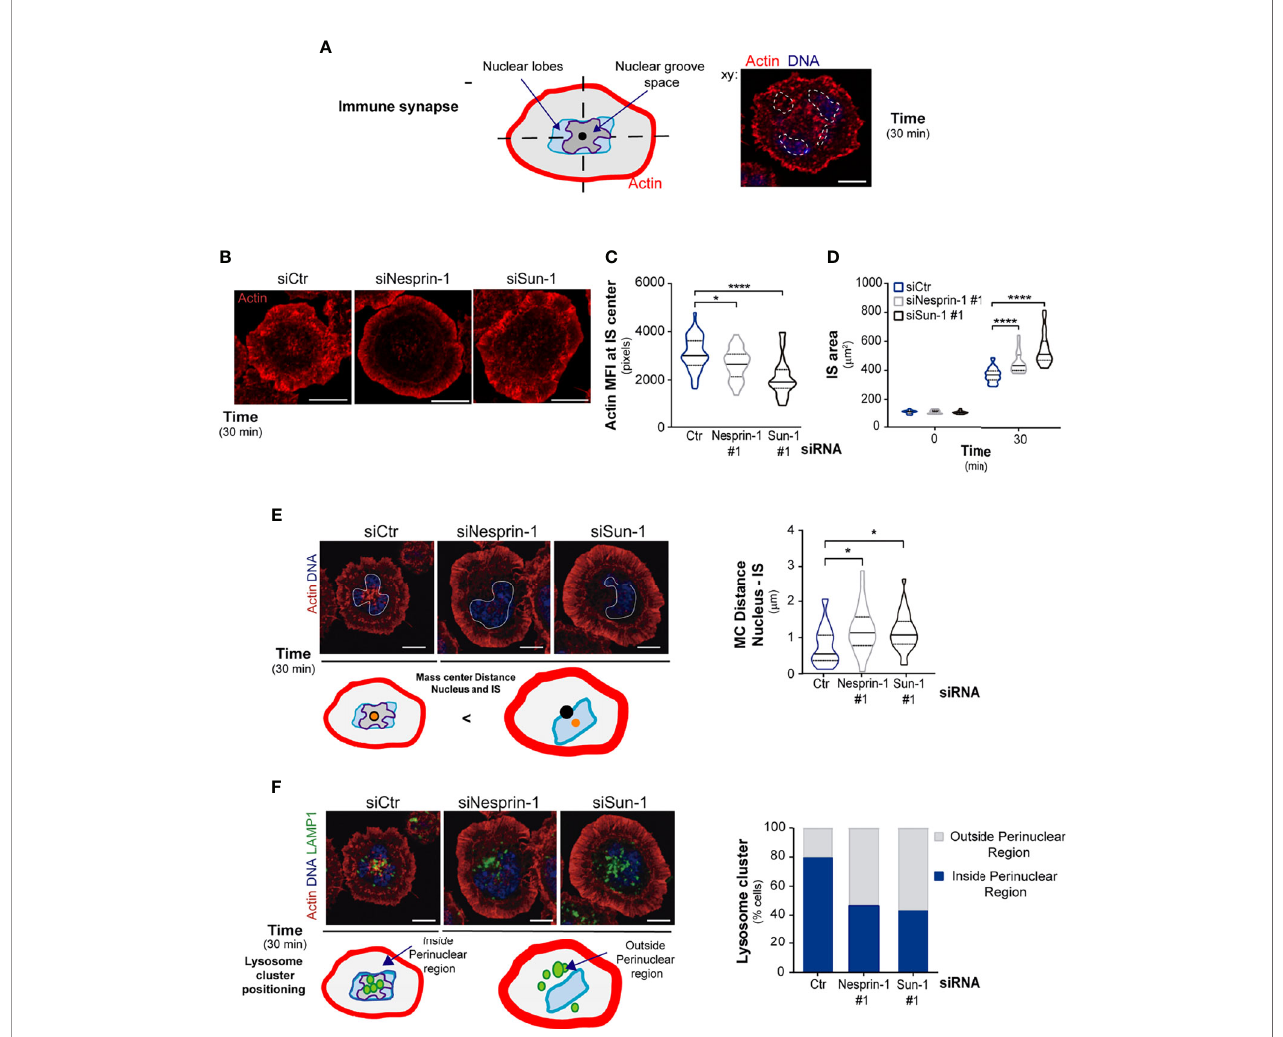
FIGURE 4 | Nesprin-1 and Sun-1 regulate immune synapse organization. (A) Scheme depicting a mature immune synapse formed by B cells. Arrows indicate nuclear groove space and position of nuclear lobes at the center of the immune synapse. Right side: a confocal image of a B cell seeded on an antigen-coated dish for 30 min, fi xed and stained for the nucleus (Hoechst, blue) and actin (phalloidin, red). Nuclear lobules are highlighted with a white line. (B – D) Representative confocal images of the actin signal at the immune synapse of B cells silenced for Nesprin-1 or Sun-1, labeled and activated as in A; quanti fi cation of central actin MFI (C) and peripheral actin, which was used to measure immune synapse area, n ≥ 60 (D) . (E, F) Confocal images of B cells activated as in A and schemes showing nuclear and lysosome positioning at synaptic center. (E) Upper panel shows cells stained for actin (red) and nucleus (Hoechst in blue, delineated with a white segmented line). Schemes below indicate, the center of mass of the immune synapse (black dot) and the nucleus center of mass (orange dot). Quanti fi cation of distance between the nucleus and immune synapse mass center (MC); n>60. (F) Upper panel shows cells stained as in E and stained for lysosomes (LAMP1, green). Schemes below indicate, lysosome positioning respect to the nucleus and the immune synapse. Quanti fi cation of lysosome cluster located outside or inside of the perinuclear region, n>60. All scale bars 5 µm. Statistical analyses: Kruskal-Wallis with Dunn ’ s multiple comparisons tests; *p < 0.05, ****p <